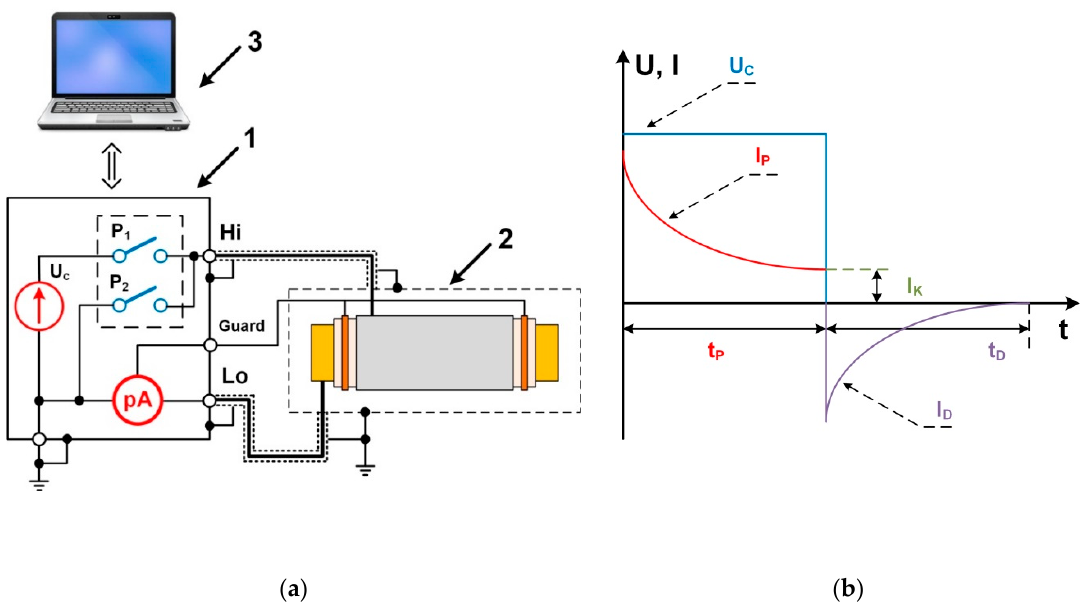
Figure 5. Diagnostics of the state of paper–oil insulation samples using the polarization and depolarization current analysis (PDC) method: ( a ) connections diagram; ( b ) time characteristics of currents and voltages. 1—measuring-switching system, 2—object being examined, 3—computer